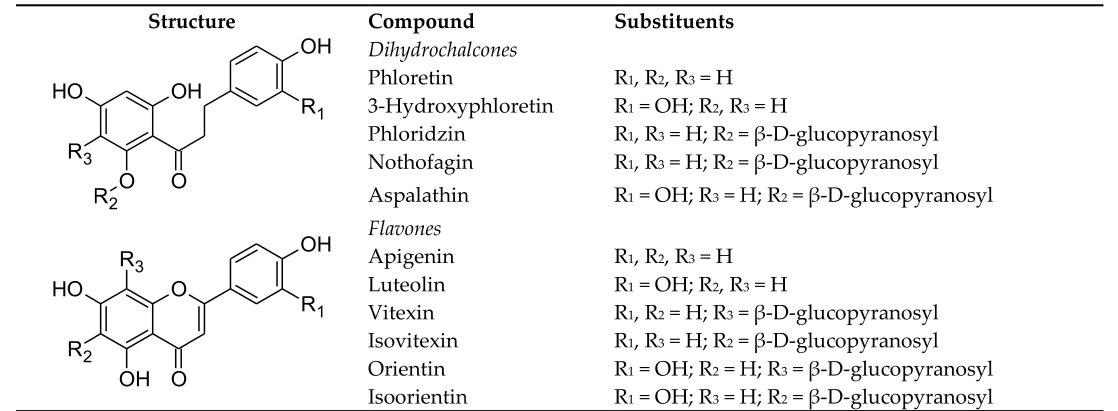
Figure 1. Molecular structures of C - and O -glucosyl dihydrochalcones and C -glucosyl flavones and